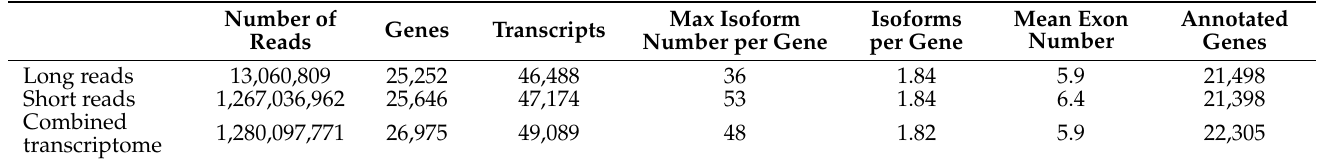
Table 3. Parameters of assembled